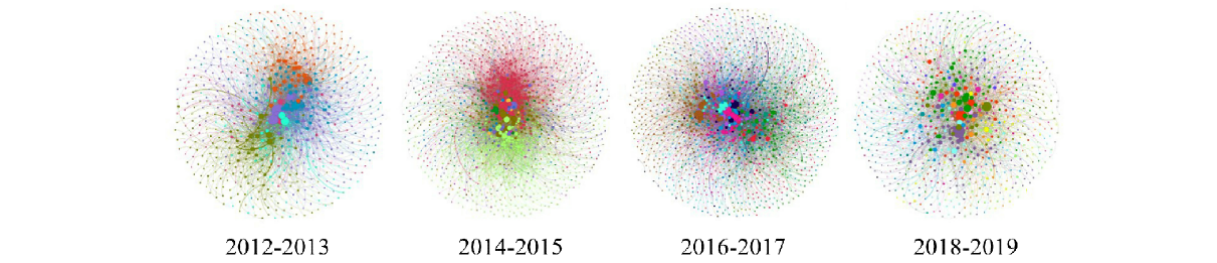
Figure 8. Changes in the community structure over